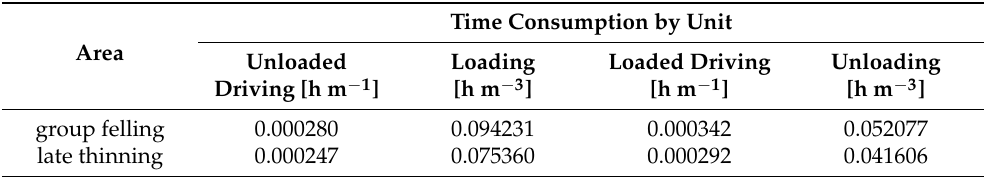
Table 3. Time consumption of forwarding with the studied